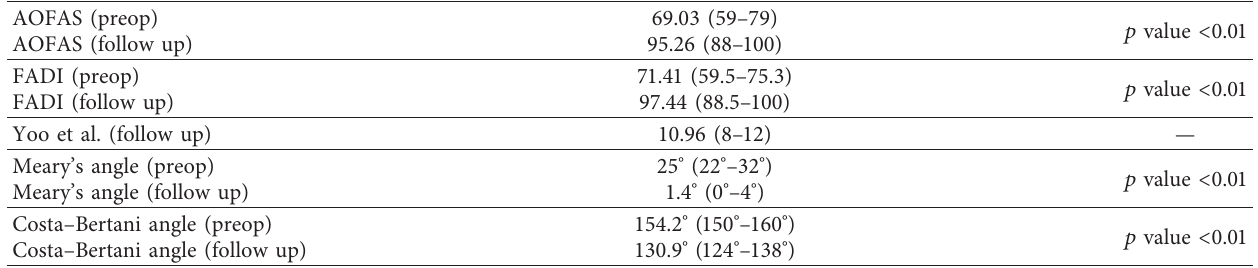
Table 1: Preoperative and final (at follow-up) clinical and radiographic results in 26 flatfeet surgically treated by Evans–Mosca technique. AOFAS